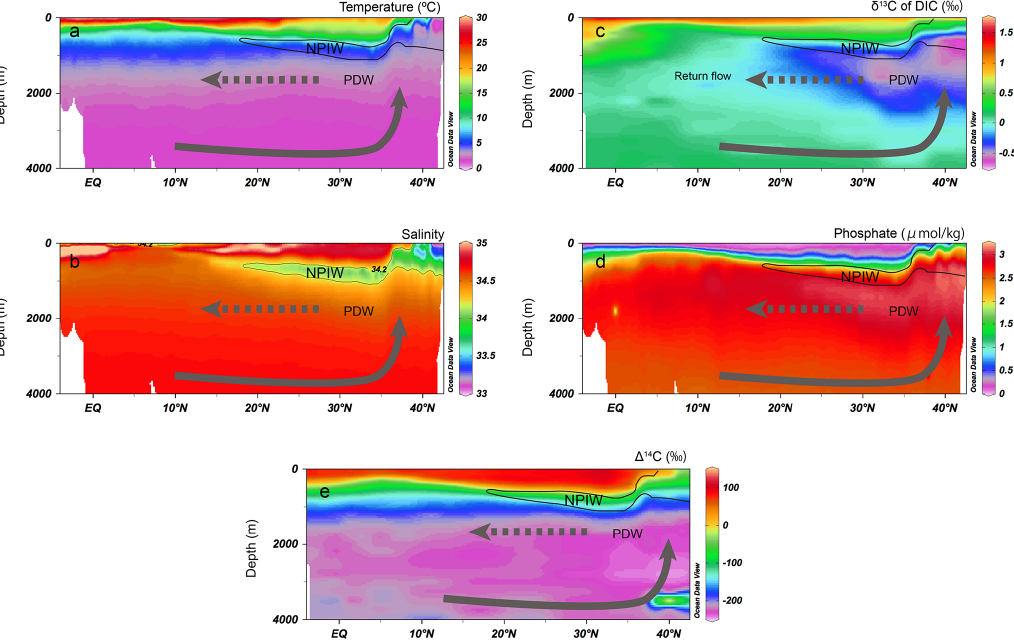
Figure 2. Latitudinal transects along WOCE Section P10: (a) temperature, (b) salinity, (c) δ 13 C of dissolved inorganic carbon, (d) phosphate concentration, and (e) (cid:49) 14 C vs. depth (0–4000m). All the data from Fukasawa et al. (2005) are available at http://cdiac.ornl.gov/oceans/ woce_p10.html. Figures are made with Ocean Data View (Schlitzer, 2009). NPIW: North Pacific Intermediate Water; PDW: Pacific Deep Water. The arrows indicate the upwelling of abyssal Pacific waters and the return flow of PDW.